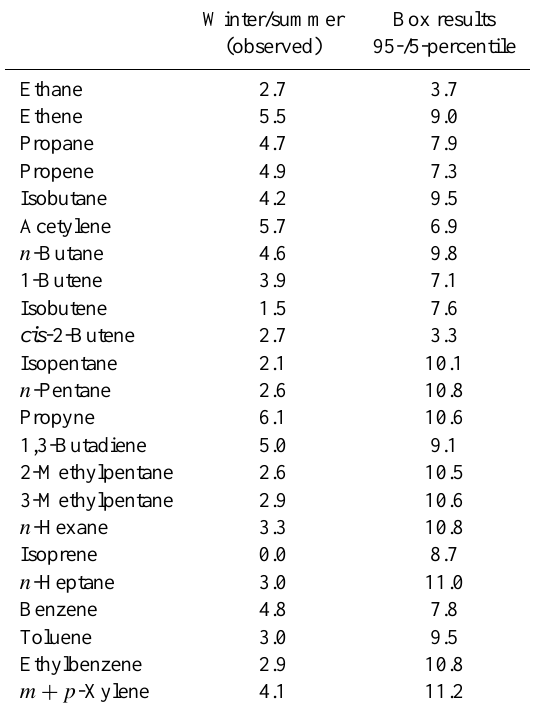
Table 2. Observed winter/summer ratios for the considered NMHCs compared to ratios obtained from box calculations using constant emissions.